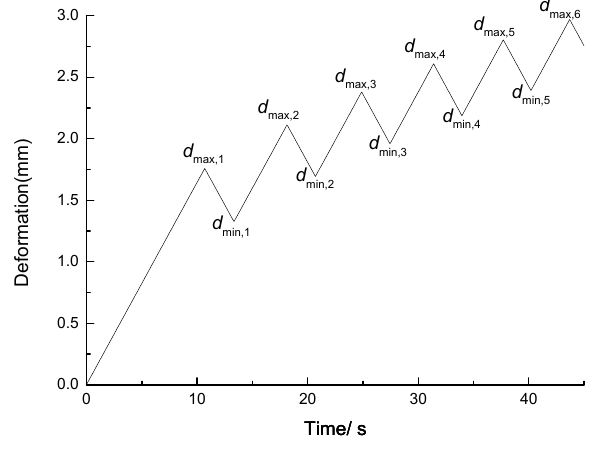
Figure 4. Deformation time.